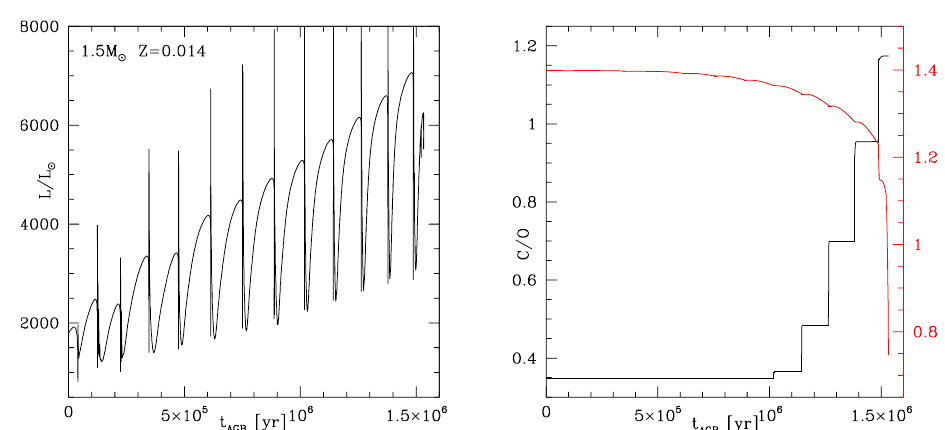
Figure 1. ( Left ) Time variation of the luminosity of a 1.5 M (cid:12) model star of metallicity Z = 0.014, during the AGB phase. ( Right ) Time variation of the surface C/O ratio (black line, scale on the left) and of the mass of the stars (red track, scale on the right) of the same model star shown in the left panel.